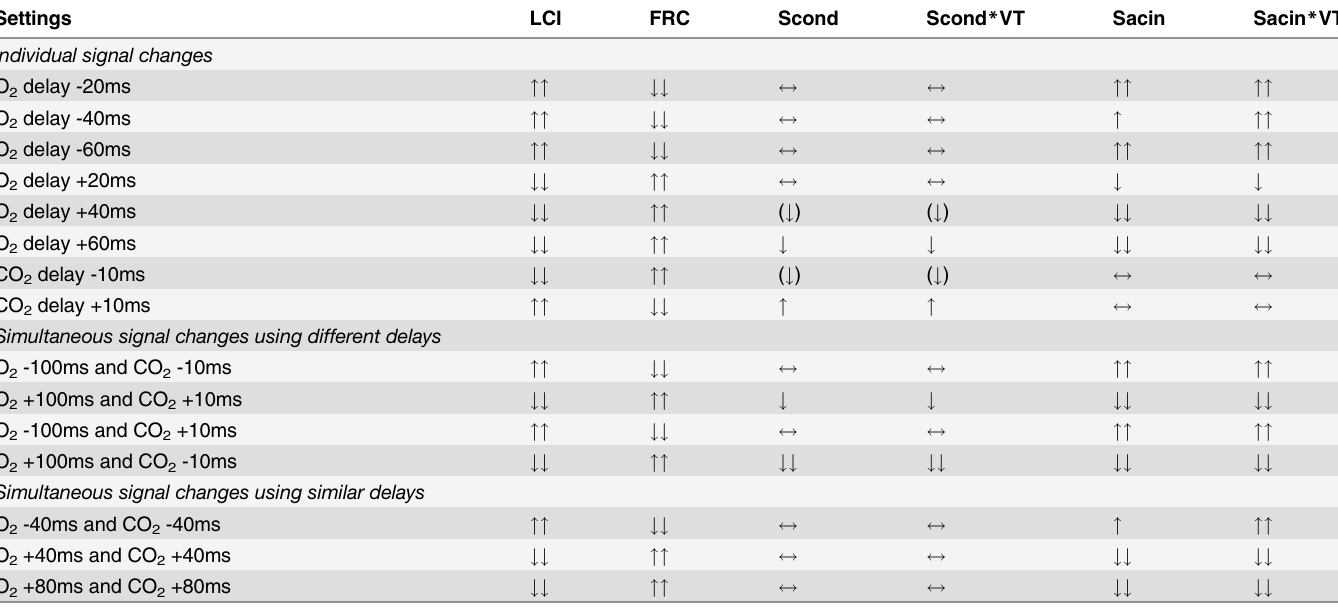
Table 8. Change of N 2 MBW results after reanalysis with different signal delay times.